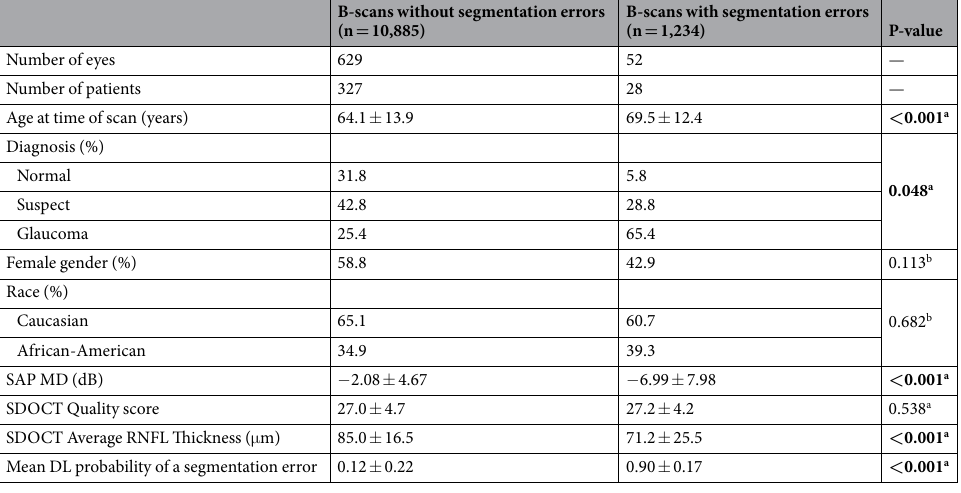
Table 2. Characteristics of the eyes and subjects in the test sample according to the presence of segmentation errors, as classified by human graders. SAP = Standard Automated Perimetry; MD = Mean Deviation; SDOCT = Spectral-Domain Optical Coherence Tomography; RNFL = Retinal Nerve Fibre Layer. Values given as mean ± standard deviation, unless otherwise noted. a Generalized estimating equation; b Fisher’s exact